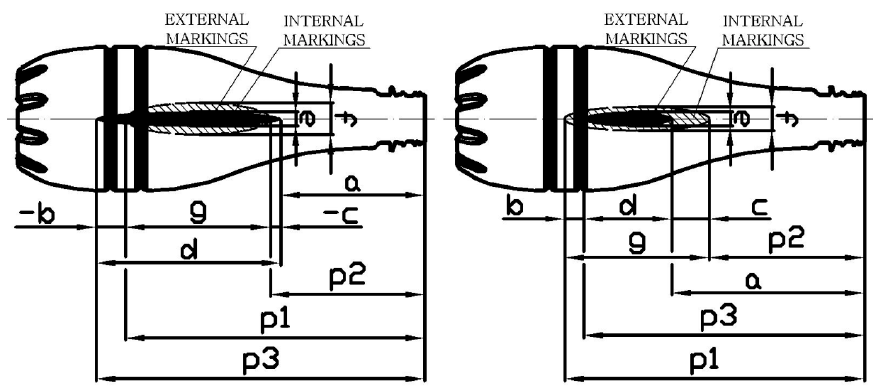
Figure 6. A way of measuring the marks that are the basis of the bottle kinetics analysis.